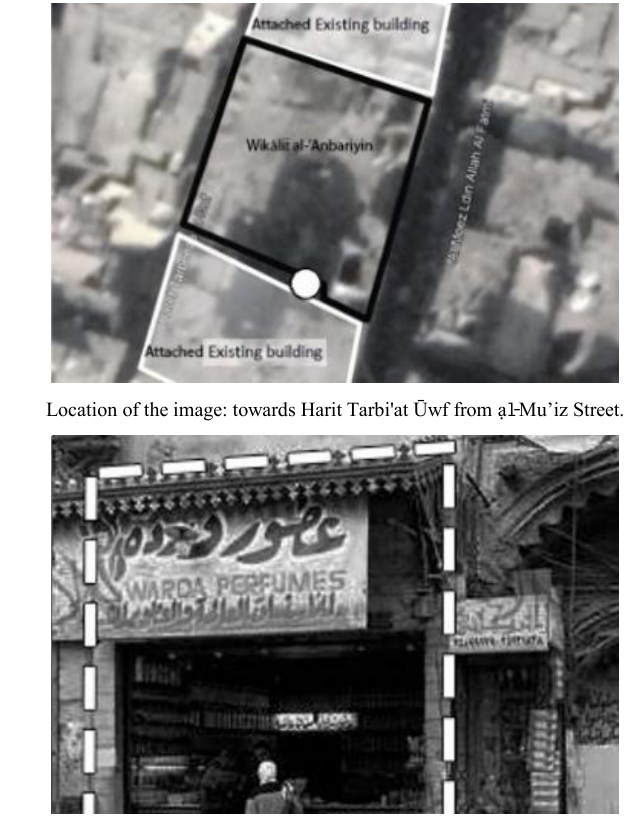
Figure 17. The white dashed rectangle indicates a shop that has its sign, before Wikāliẗ ạl-’Anbariyin demolition. Source: Al-Ahram online article, 2016